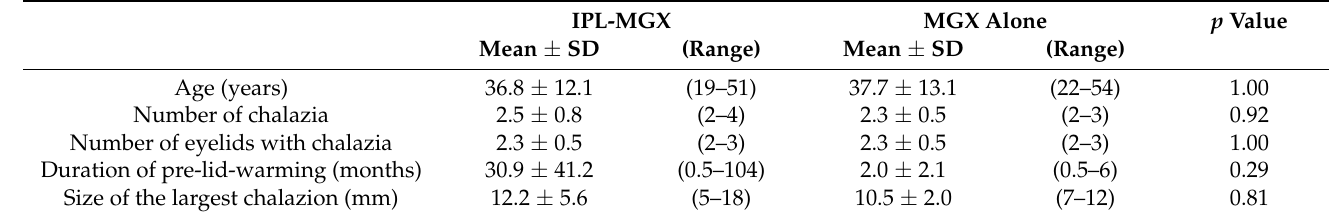
Table 1. Demographics of the patients with chalazion in Intense pulsed light (IPL)–meibomian gland expression (MGX) ( n = 6) and MGX alone ( n = 6)